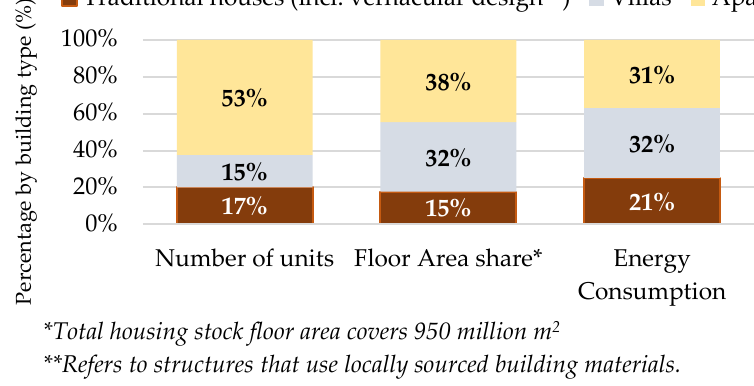
Figure 1. Breakdown of KSA’s housing stock based on type [8].